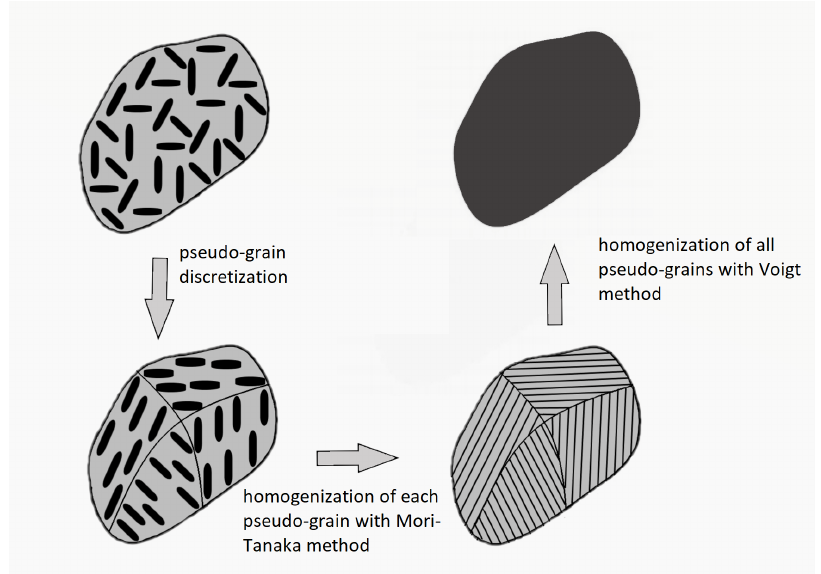
Figure 1. Steps used during homogenization procedure: (i) pseudo-grain discretization, (ii) homoge- nization of each pseudo-grain, (iii) homogenization of all pseudo-grains with Voigt